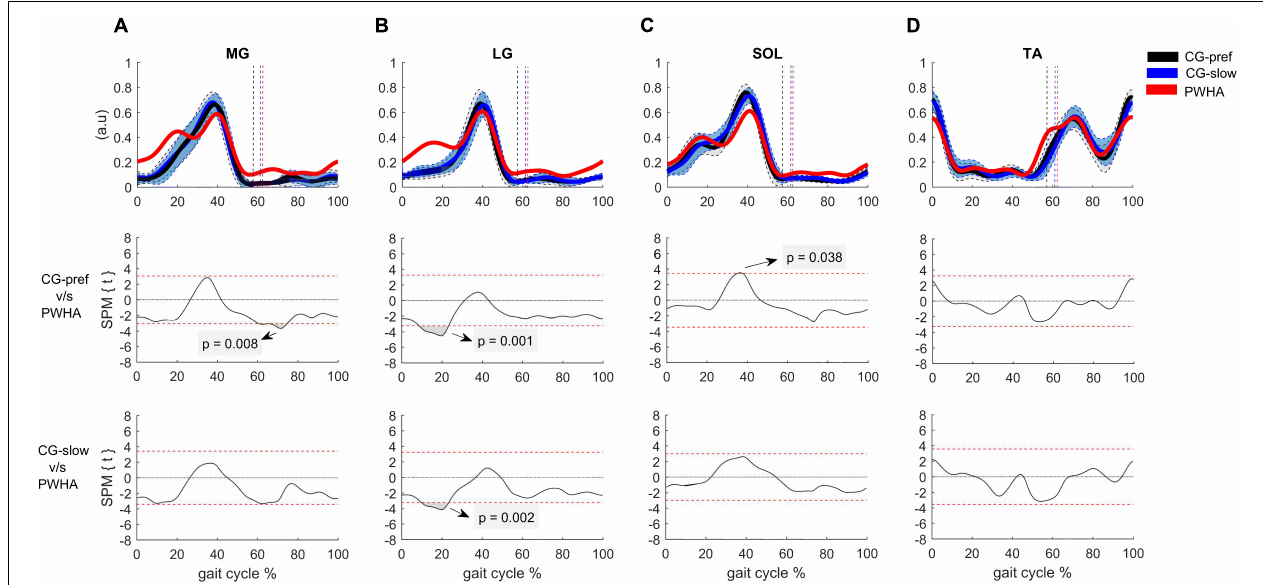
FIGURE 2 | Comparison between groups of surface electromyography of muscles crossing the ankle. (A) Medial gastrocnemius (MG). (B) Lateral gastrocnemius (LG). (C) Soleus (SOL). (D) Tibialis anterior (TA). (Top row ) Surface electromyography of muscles crossing the ankle of people with hemophilic arthropathy (PWHA; n = 14) at their preferred velocity (red), the control group ( n = 13) at their preferred velocity (CG-pref, black), and during the slow velocity condition (CG-slow, blue). Data are plotted as a function of normalized step time (0, heel strike) and expressed as mean with 95% confidence interval for CG. Vertical dashed lines indicate transition from stance to swing phase (black, CG-pref; blue, CG-slow; red, PWHA). (Bottom two rows) Time-dependent t values of the statistical parametric mapping (SPM) for groups comparison. Horizontal red dashed line indicates p = 0.05 level. Gray zones indicate regions with statistically significant differences. a.u, Arbitrary